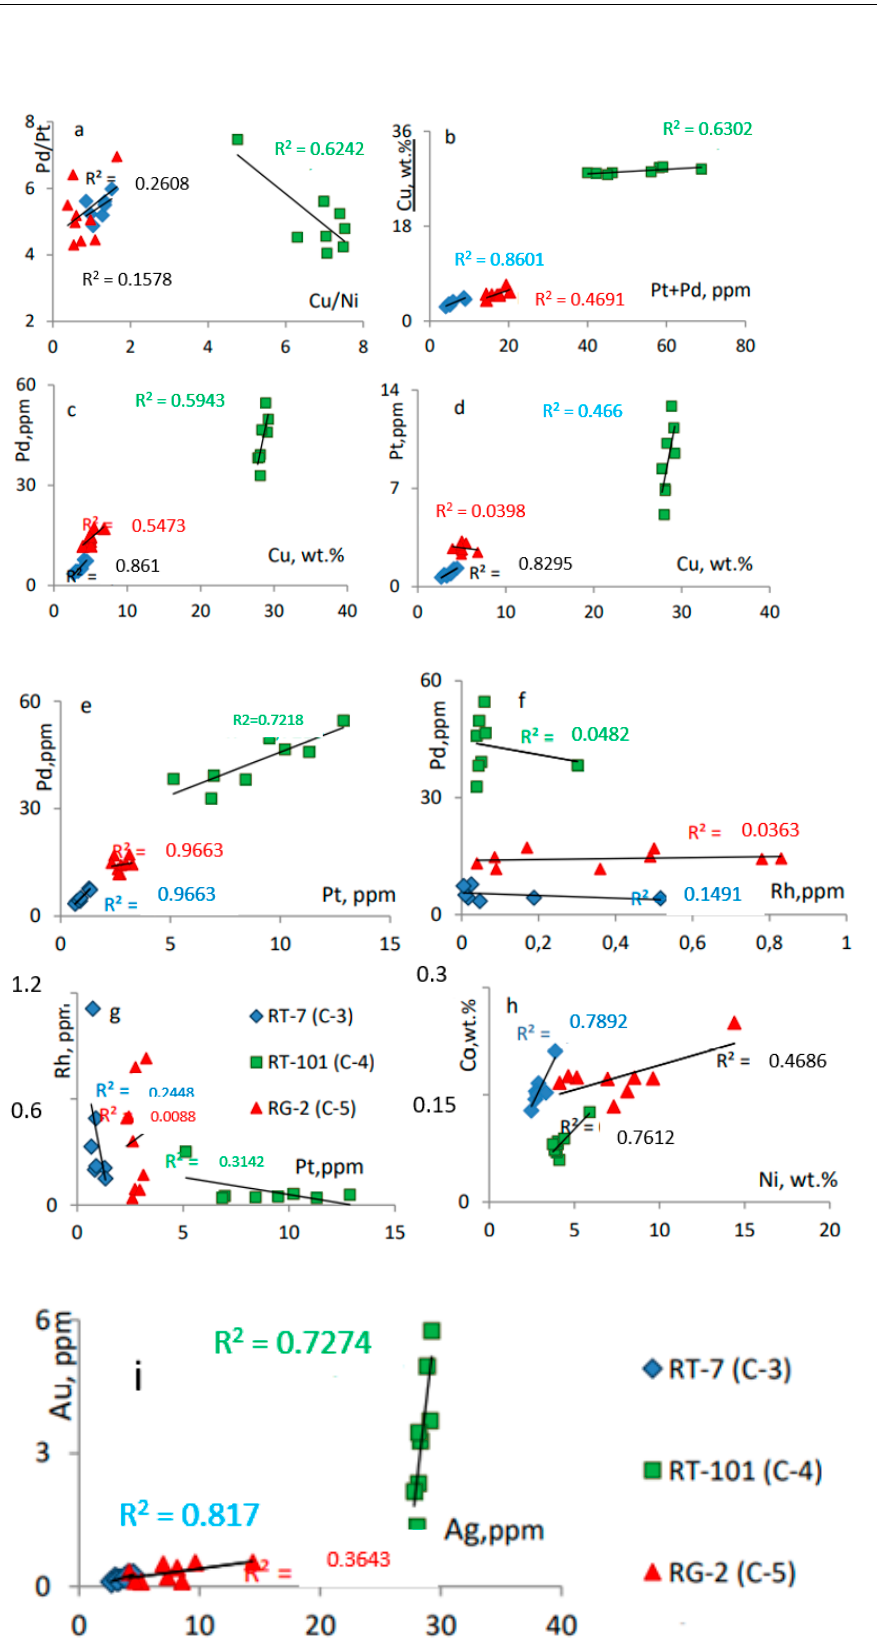
Figure 13. ( a – i ) Relationships of metals on massive sulfide ore in C-3, C-4 and C-5 orebodies. Figure 13. Relationships of metals in massive sulfide ores in C-3, C-4 and C-5 orebodies. ( a ) Cu/Ni- Pd/Pt; ( b ) Pt+Pd-Cu; ( c ) Cu-Pd; ( d ) Cu-Pt; ( e ) Pt-Pd; ( f ) Rh-Pd; ( g ) Pt-Rh; ( h ) Ni-Co; ( i ) In general, it should be noted that the largest variations of elements occur in the C-4 orebody, while C-3 and C-5 orebodies are characterized by a very consistent ore